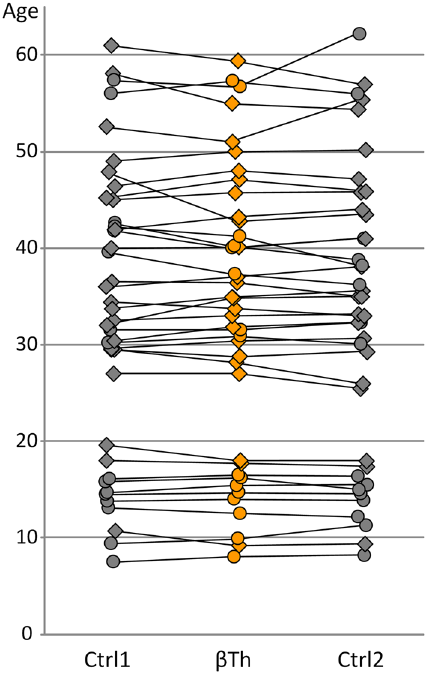
Figure 1. Age distribution of the βTh group (centre) and the control group (left and right). Lines connect matched subjects. Circles: females; diamonds: